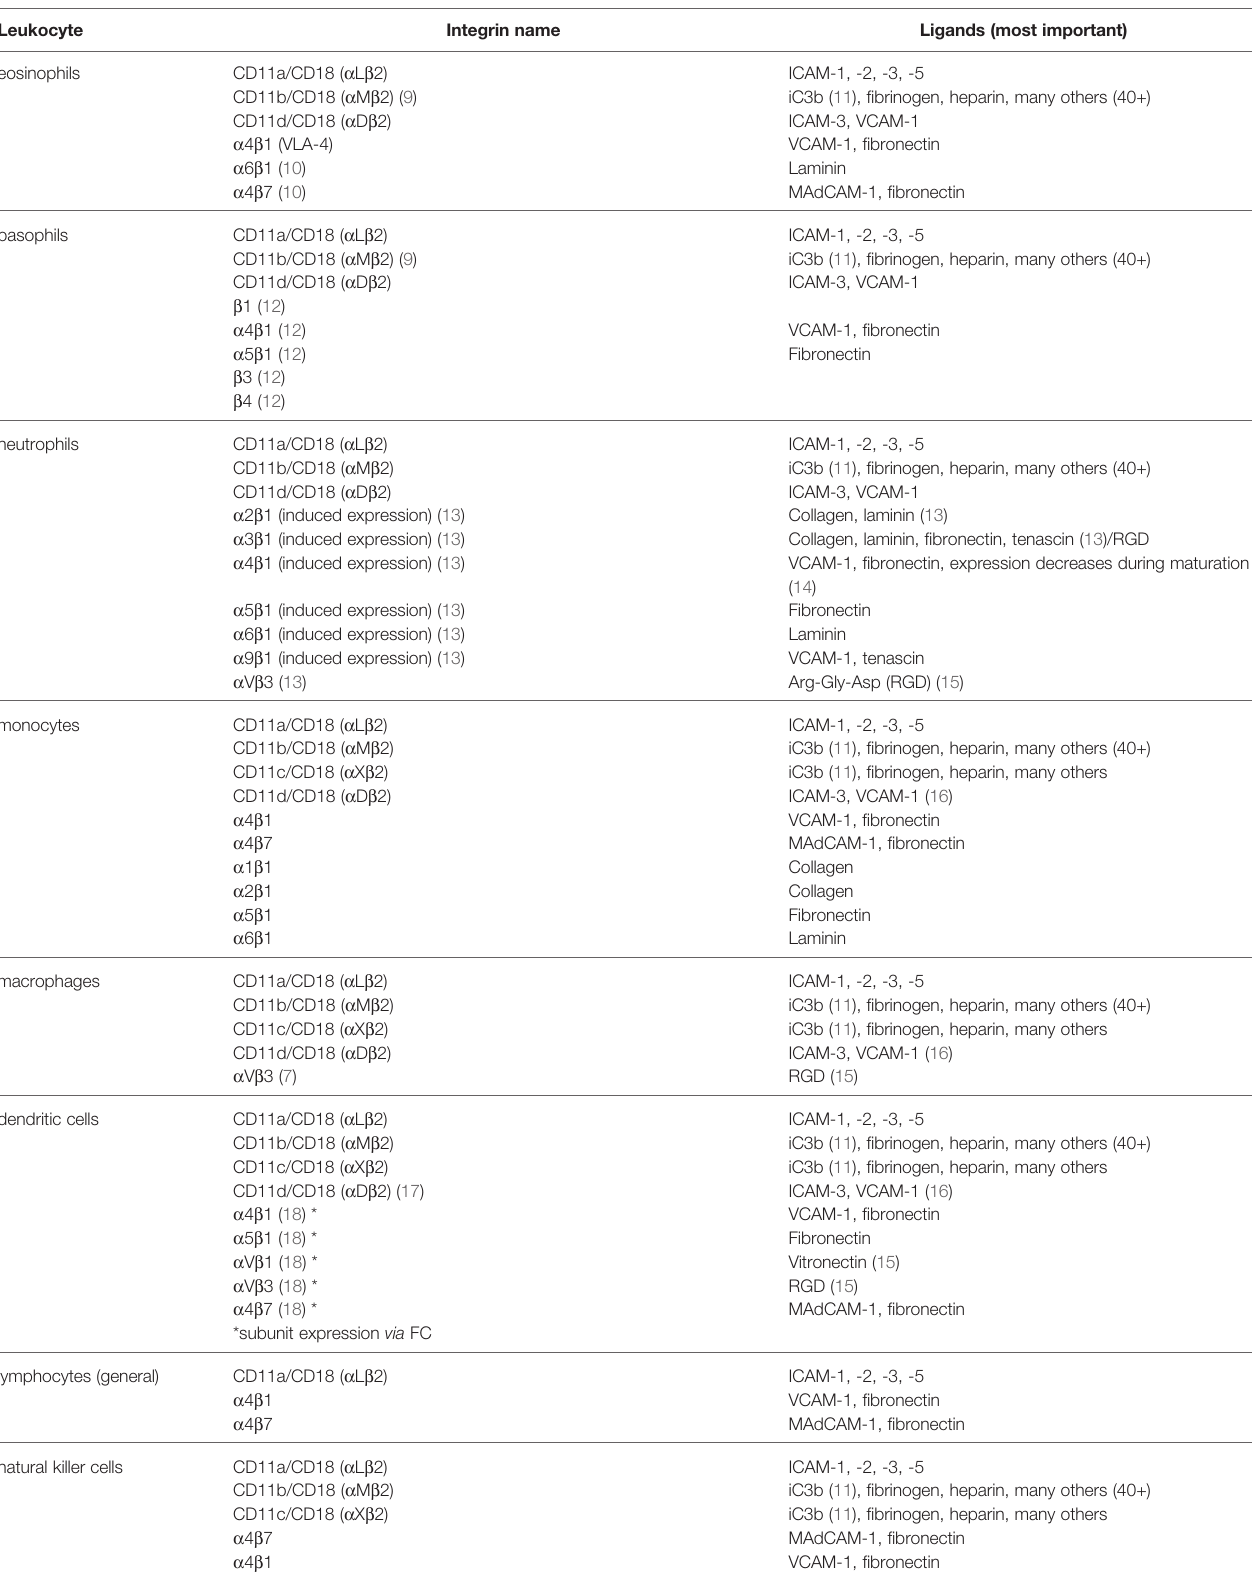
TABLE 1 | Leukocyte Integrins And Their Ligands, Expanded On From